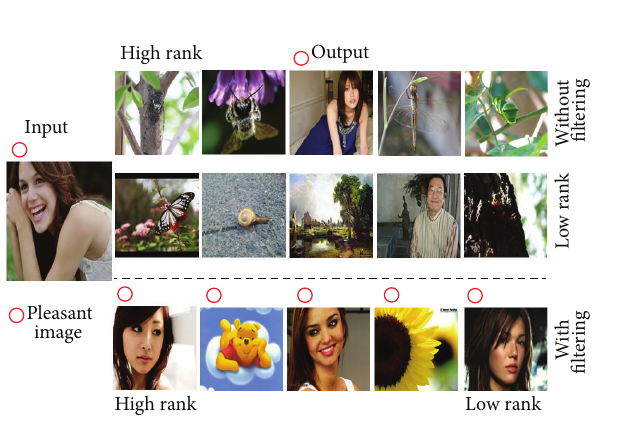
Figure 6: Output results, example 1.